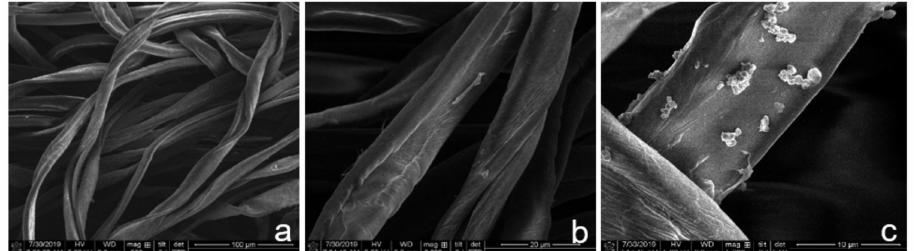
Figure 7. Scanning electron microscope(SEM) images of ( a , b ) TACGauze (TGz) untreated at magnifi- cations of 500 × and 1200 × , respectively, and ( c ) BIOGauze (BGz) magnified 5000 ×